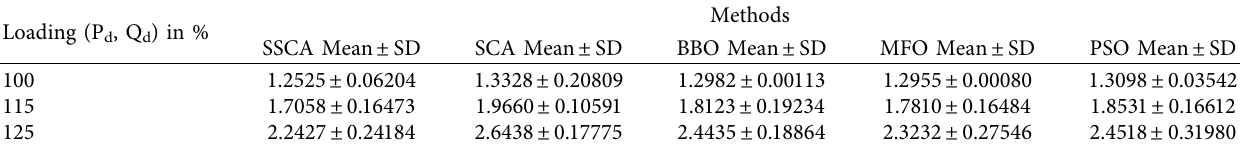
Table 8: Statistical analysis of APL for IEEE 118 bus system.